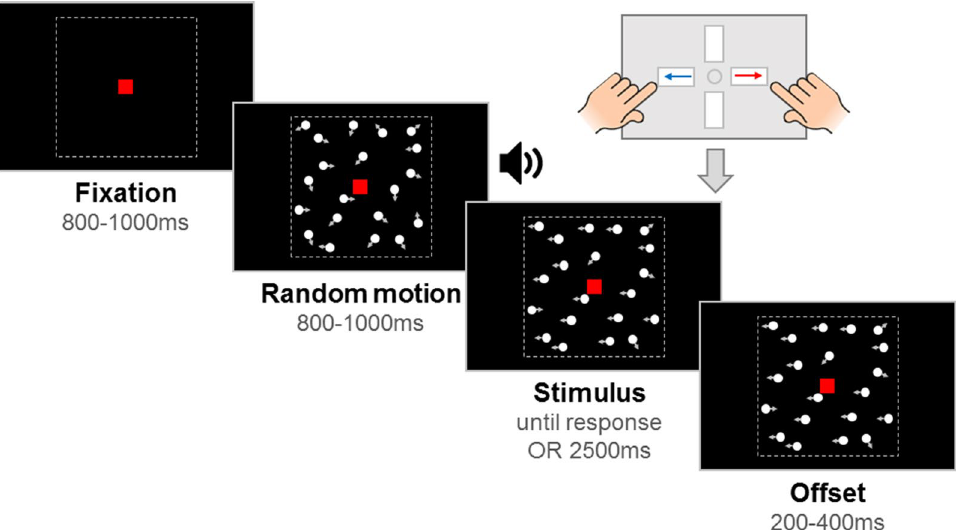
Figure 2. Schematic representation of trial procedure. An initial fixation period was followed by a random motion period consisting of randomly moving dots. Next, the stimulus period contained leftward or rightward global motion and lasted until the child reported the direction with a response box. If there was no response, the stimulus remained on the screen for 2500 ms. The stimulus remained on the screen for an offset period after the response or after the maximum stimulus duration was reached. Note that arrows (indicating movement) and dotted lines (marking the square stimulus region) are shown for illustrative purposes only. Figure reproduced from https:// osf. io/ wmtpx/ under a CC-BY4.0